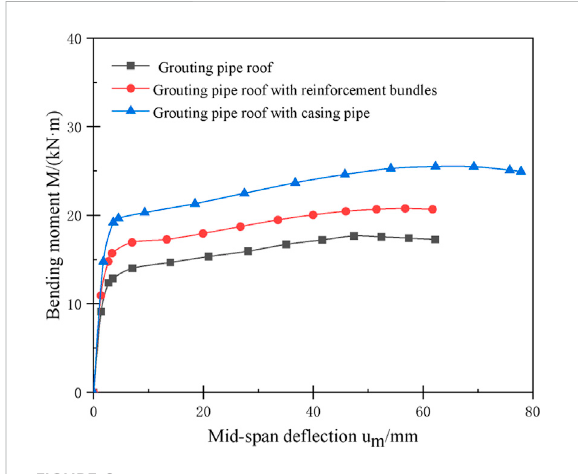
FIGURE 7 Ultimate bearing capacity coef fi cient-grouting incompleteness curve of pipe